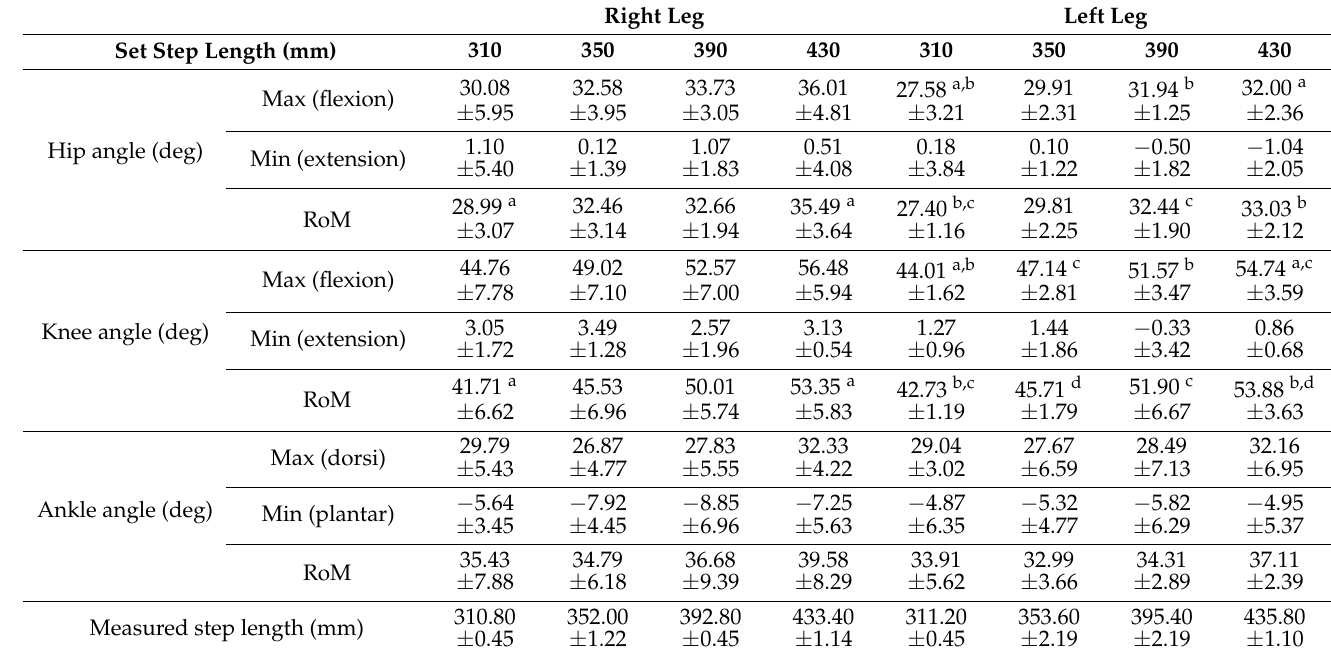
Table 1. Results of the joint angle by step length. Right Leg Left Leg